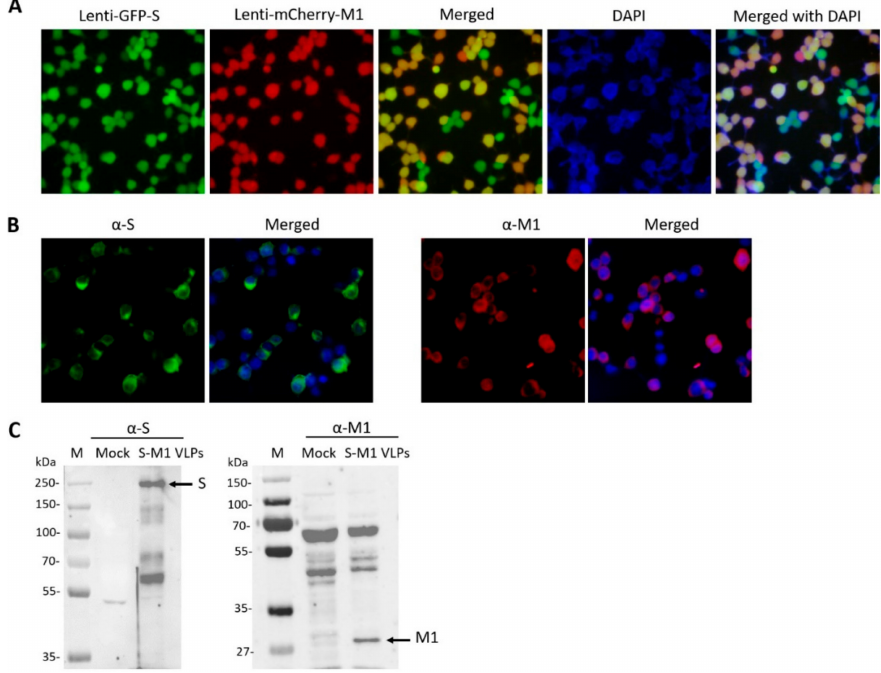
Figure 2. Characterization of the HEK293T-S-M1 cell line. ( A ) HEK293T cells were transduced with Lenti-GFP-S and Lenti-mCherry-M1. Cells were treated with DAPI before fluorescence microscopy. ( B ) HEK293T-S-M1 cells were seeded into an 8-well chamber slide. After fixation and blocking, cells were stained with either rabbit α -S antibodies followed by goat α -rabbit Alexa Fluor ® 488, or α -M1 antibodies followed by goat α -mouse IgG Alexa Fluor ® 647. Slides were imaged by fluorescence microscopy. ( C ) HEK293T-S-M1 cell lysates were harvested and lysed for Western blotting. Lysates were either probed with rabbit α -S or mouse α -M antibodies. Goat α -rabbit or α -mouse IgG HRP were used as secondary